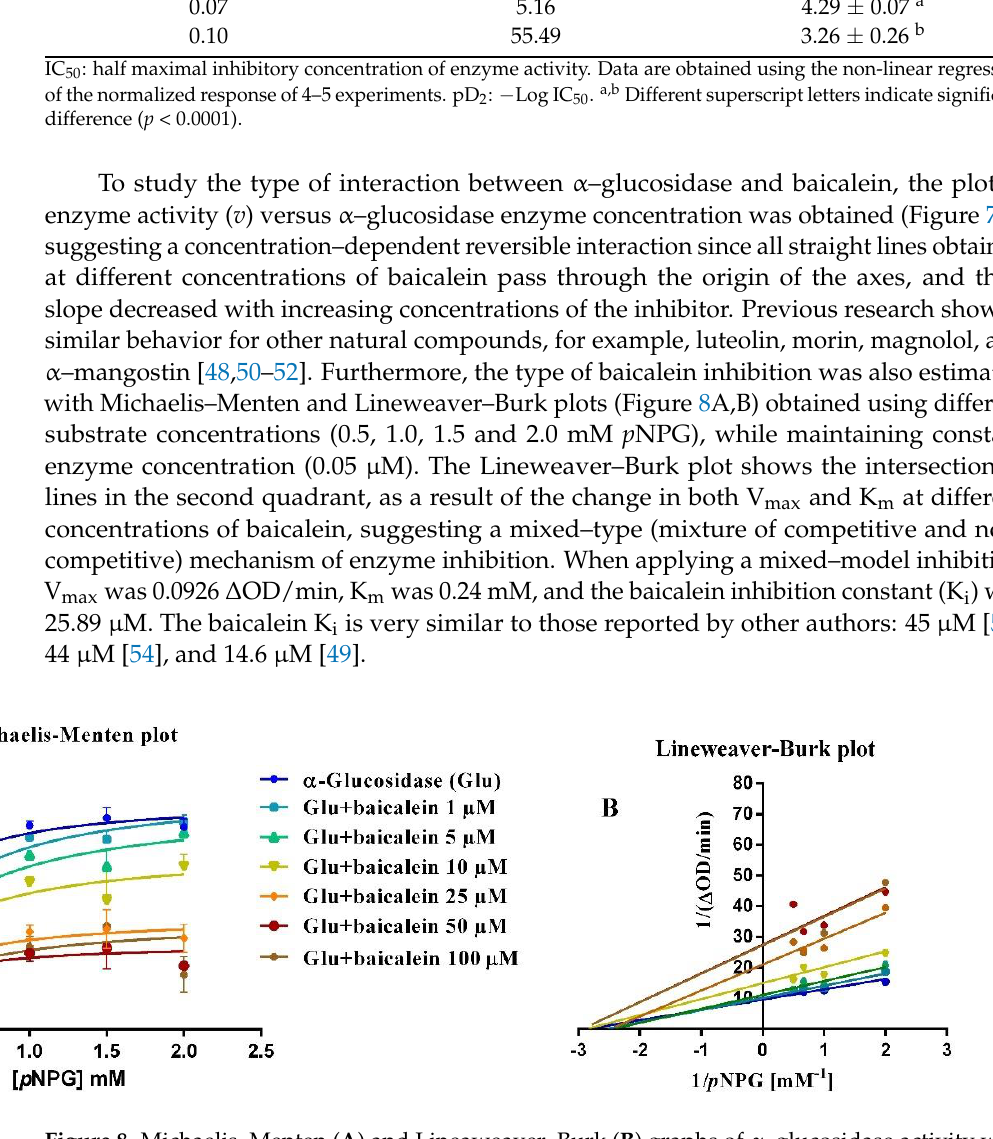
Figure 8. Michaelis–Menten ( A ) and Lineaweaver–Burk ( B ) graphs of α –glucosidase activity with Figure 8. Michaelis – Menten ( A ) and Lineaweaver – Burk ( B ) graphs of α– glucosidase activity with different substrate concentrations (0.5–2.0 mM pNPG) in the presence of baicalein (1–100 µ M). Data different substrate concentrations (0.5 – 2.0 mM pNPG) in the presence of baicalein (1 – 100 µM). Data are obtained from 4–5 are obtained from 4 – 5 experiments.